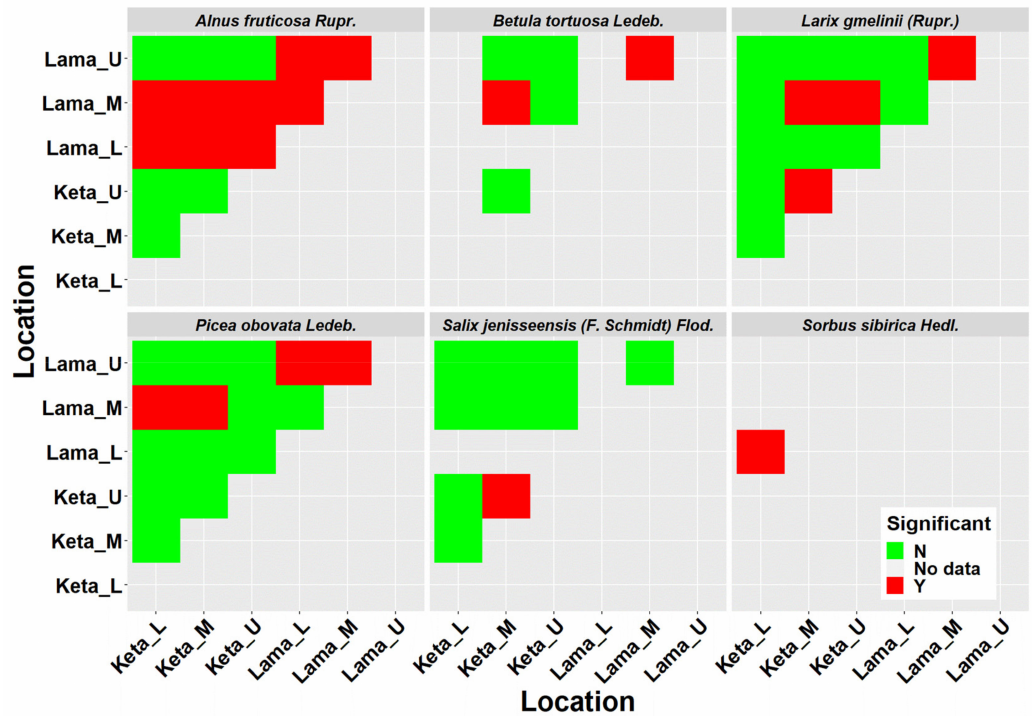
Figure A2. ANOVA-based statistical comparison of derived height-diameter models (Table 1). N means not significant, Y means significant at 95% significance level. L, M, U represent lower, middle, and upper elevational zones, respectively.